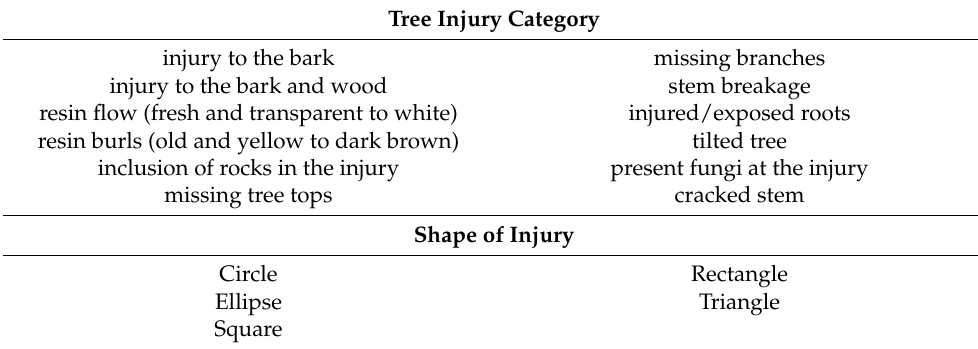
Figure 3. The examples of most common injuries: ( a ) injury to the bark, ( b ) injury to the bark and wood, ( c ) resin flow (fresh and transparent to white), ( d ) resin burls (old and yellow to dark brown), ( e ) inclusion of the rocks in the injury, and ( f ) cracked steam. Table 2. The list of all tree injury categories and parameters of each injury—shape of the injury and injury